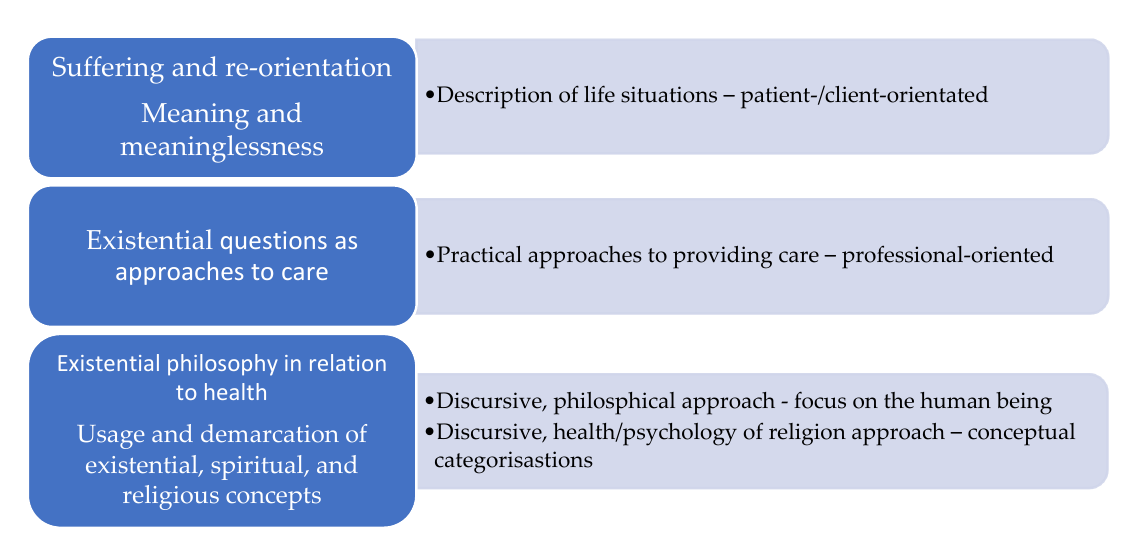
Figure 3. Three dimensions of the overarching themes of ‘existential’.